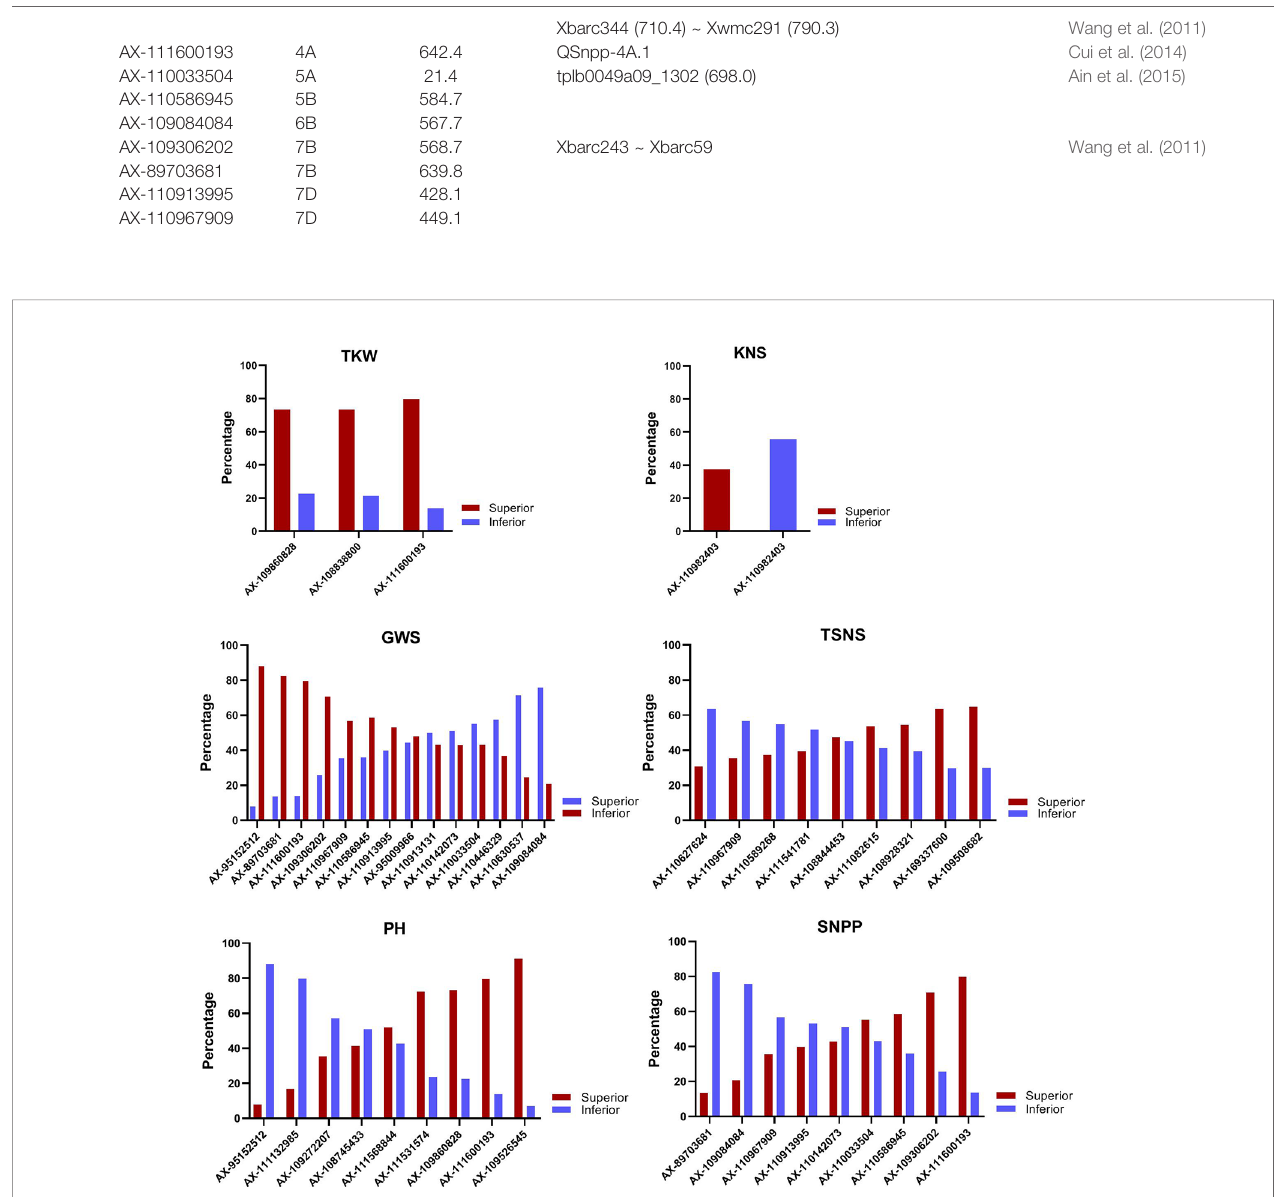
FIGURE 3 | The percentage of cultivars with superior alleles at different signi fi cant loci for six